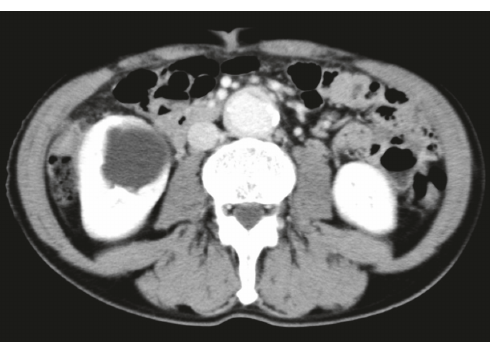
Figure 1: CT scan when the patient was first diagnosed with IgG4-RD with peritoneal fibrosis and periaortitis. CT, computed tomography; IgG4-RD, IgG4-related disease.